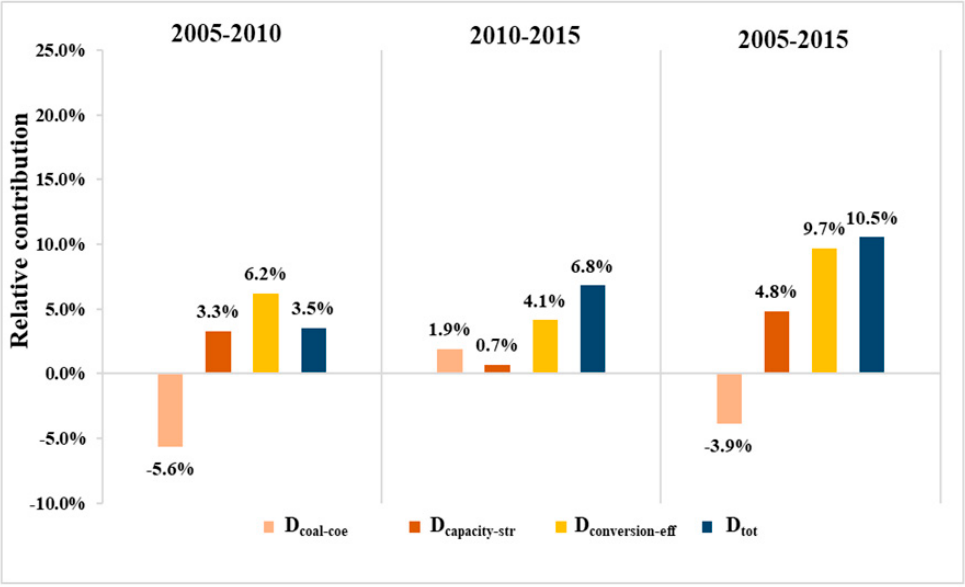
Figure 14. Relative contributions of driving factors of coal-fired power and heat generation in China from 2005 to 2015.